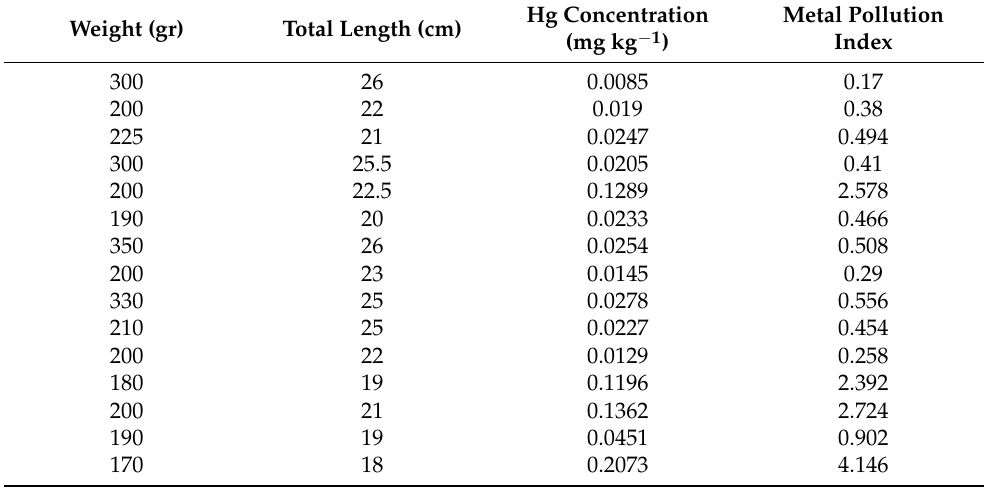
Table 2. Size measurements and Hg concentration in Oreochromis niloticus from Lake La Sabana. Weight